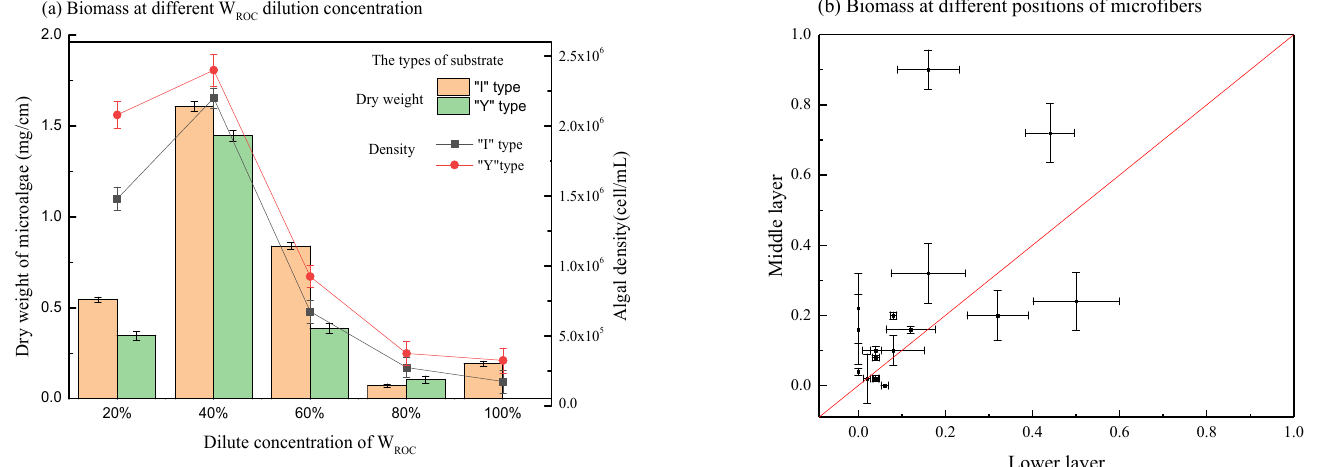
Figure 3. Algae density and dry weight that was harvested from an attached microalgae-simulated plant system. ( a ) Biomass at different W ROC dilution concentrations; ( b ) biomass in different substrate positions (the biomass came from one branch).